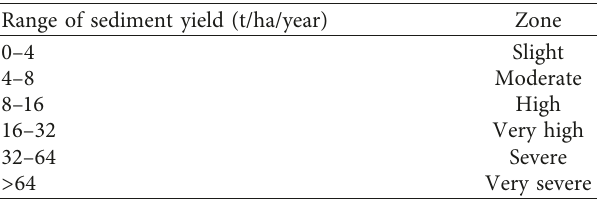
Table 6: Class assigned for degree of